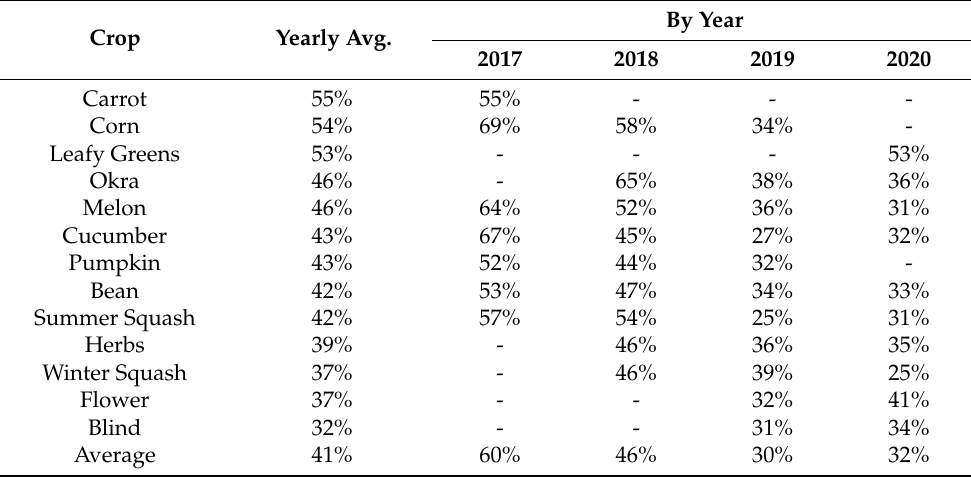
Table 2. Data return rate by crop by year from 2017 to 2020. Data are presented in descending order from the highest yearly average data return rate. Crops that do not have data for a specific year were not offered as trials in that year. Data for youth trials are not presented as these trials were primarily for outreach purposes, and data was not requested in return. Tomato data is also not presented as these trials were first offered in 2021, and data collection and data are incomplete.